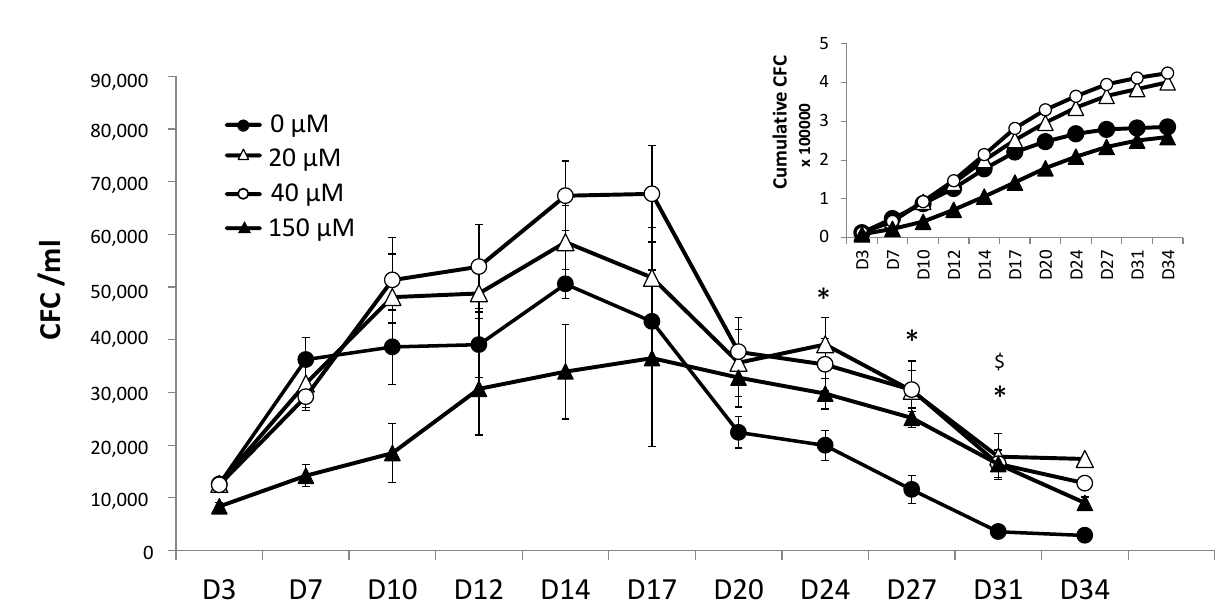
Figure 2. Potential for generating committed progenitors in secondary culture, n = 6. The cumulative curve, where the value for each time point is a sum of the values for all previous time points, is presented in the inset. αTOA was present only in the primary culture (for 3 days); the cells were then washed and seeded in the same supplemented medium in the secondary cultures. Data are presented as mean +/− SD. * p < 0.05 (0 µM compared to 20µM), $ p < 0.05 (0 µM compared to 40 µM).